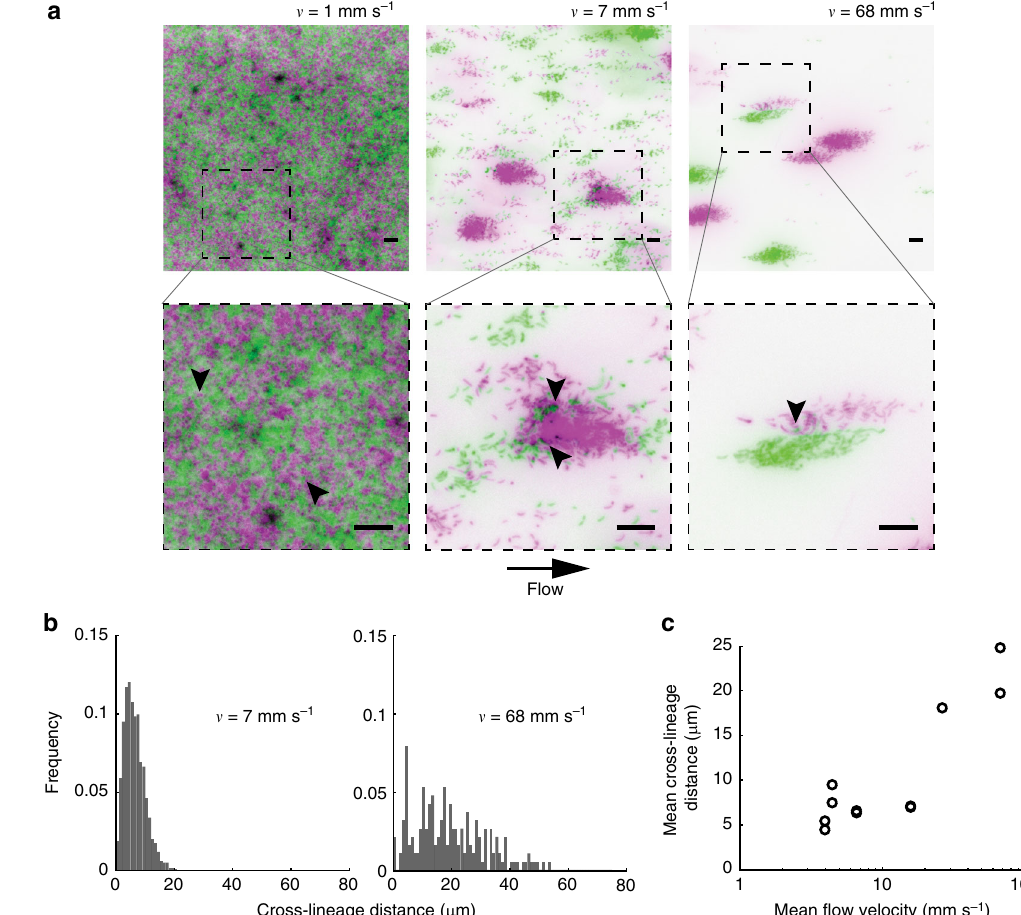
Fig. 3 Flow modulates clonal structuring of C. crescentus bio fi lms. a Fluorescence microscopy images of C. crescentus bio fi lms (24 h). Two populations at equal density, expressing either mKate or Venus fl uorescent proteins, were initially loaded in microchannels. The bottom row of images highlights the presence of invading cells (indicated by black arrowheads) within otherwise clonal clusters. Green: C. crescentus mKate. Magenta: C. crescentus Venus. Scale bars: 10 μ m. b Distribution of cross-lineage colony distances (i.e., distance between green colonies and their nearest magenta neighbor, and vice versa) for two representative mean fl ow velocities (7 and 68 mm s − 1 ). The distribution broadens as fl ow velocity increases. c Cross-lineage colony distance, which can be used as a measure of clonal segregation, as a function of mean fl ow velocity. As fl ow velocity increases, the mean cross-lineage distance